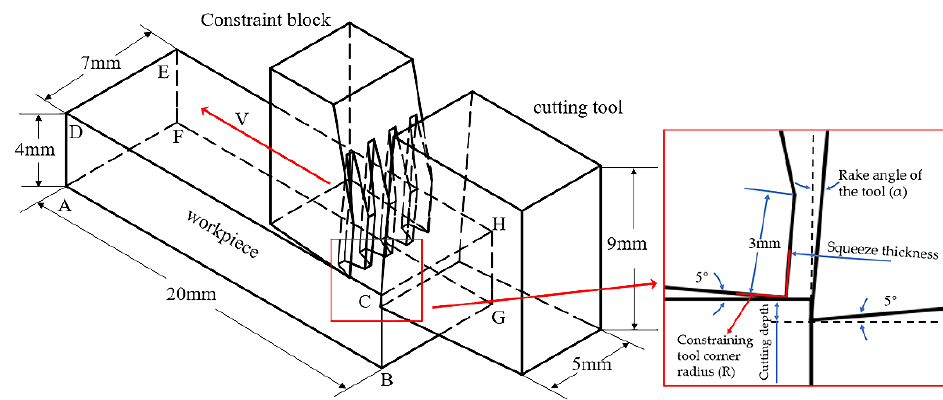
Figure 1. Finite element model of extruding-machining.